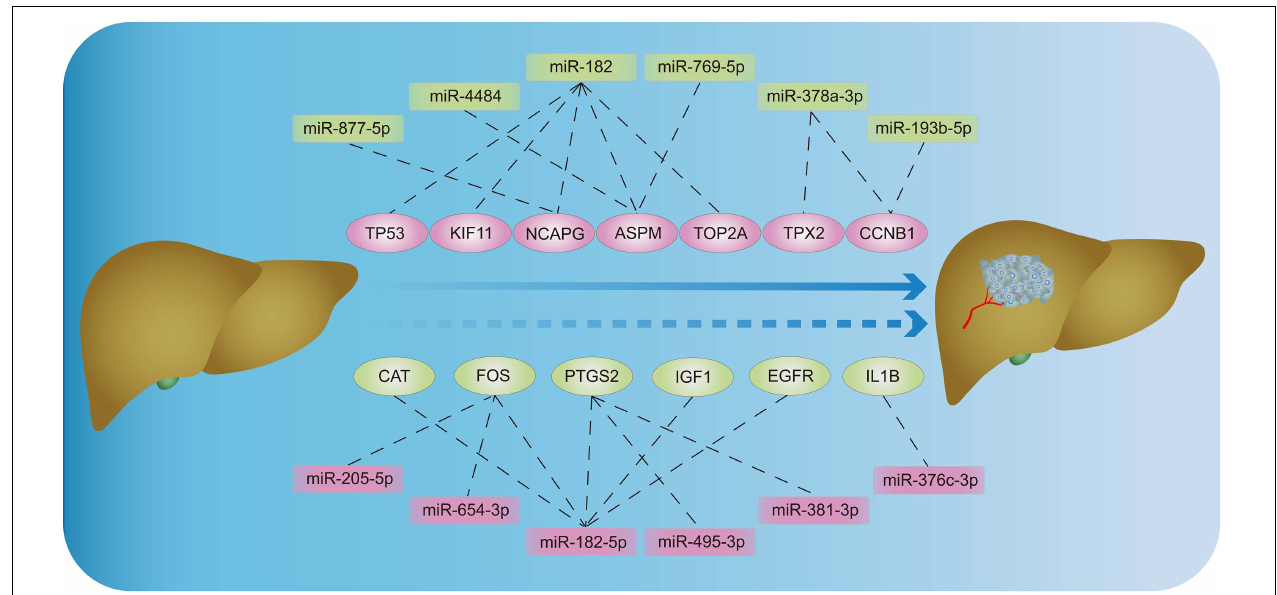
FIGURE 9 | The potential miRNA–mRNA interaction network involved in HB. HB: hepatoblastoma.